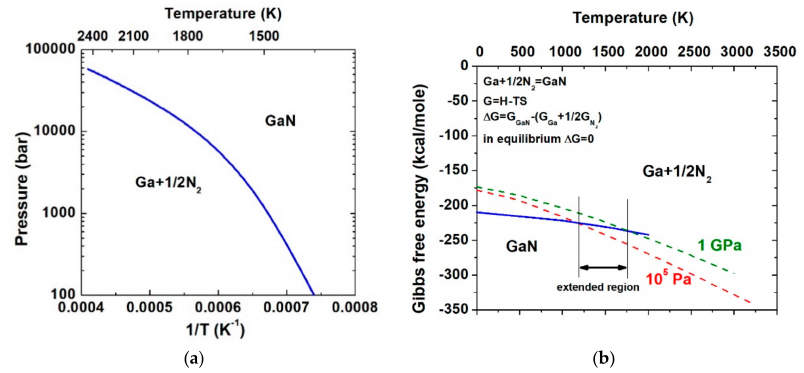
Figure 1. ( a ) Experimental p–T equilibrium curve for the GaN-Ga-N 2 system [9]; ( b ) Gibbs free energy (G) for GaN and N 2 ; visible temperature shift of GaN stability area if N 2 pressure is increased [11].